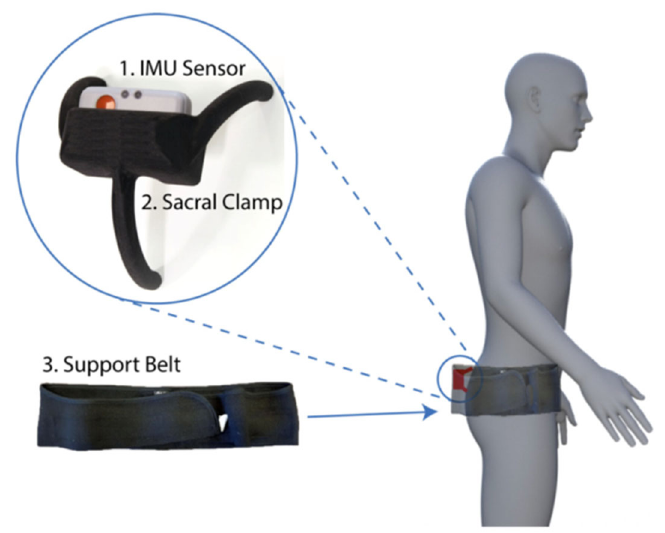
Figure 1. The three components of the device used to track pelvic motion: the inertial measurement unit (IMU) sensor, a bespoke sacral clamp and support belt. The device was attached across the sacrum and held in place by a pregnancy support belt. This belt was made from elasticated material allowing the individual to move freely, whilst holding the sacral clamp firmly in place. The sacrum had the least amount of skin/fat thickness between the device and the pelvic bone and hence it provided a feasible location to place the device for accurate pelvic tracking.